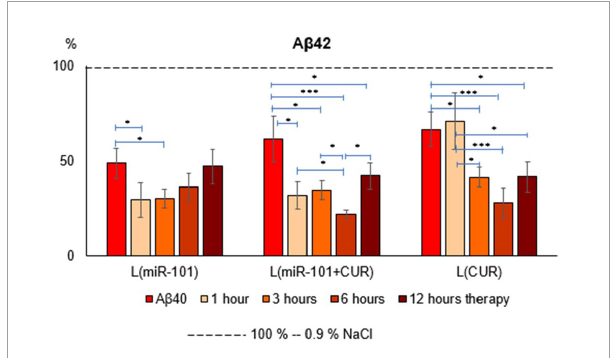
FIGURE1 Diagrams of the relative content of A β 42 in suspension of mononuclear cells after 1 h of incubation with aggregates of A β 40 and subsequent incubation over time for 1, 3, 6 and 12 h with liposomal forms of miR-101, CUR, and miR-101 + CUR. The vertical axis is the concentration of A β 42 in the target samples normalized to the corresponding concentration of this substance in the suspension of mononuclear cells incubated with saline, %. * P < 0.05, *** P <